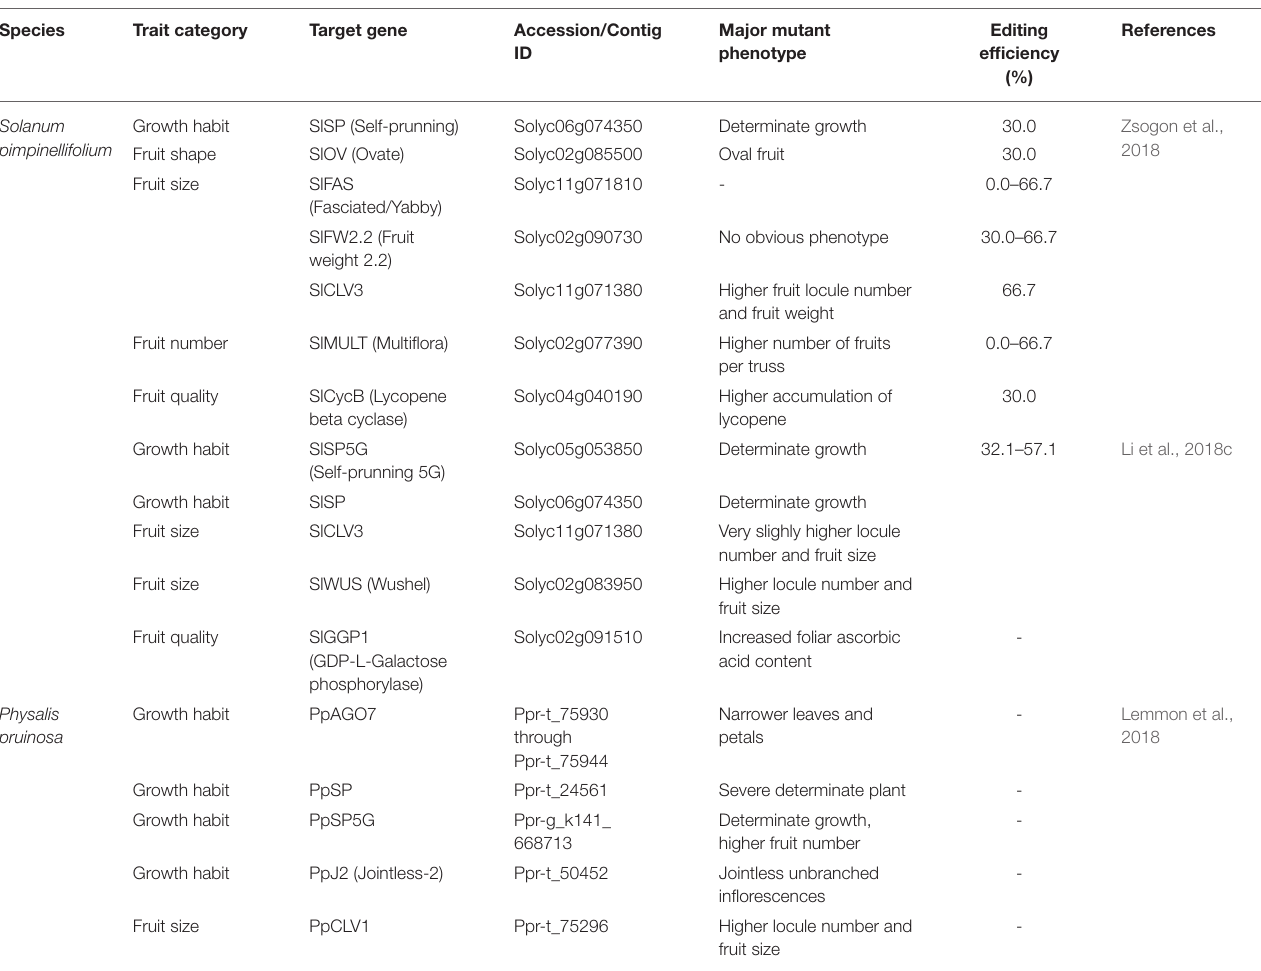
TABLE 2 | De novo domestication of Solanaceae using multiplexed CRISPR/Cas tools.